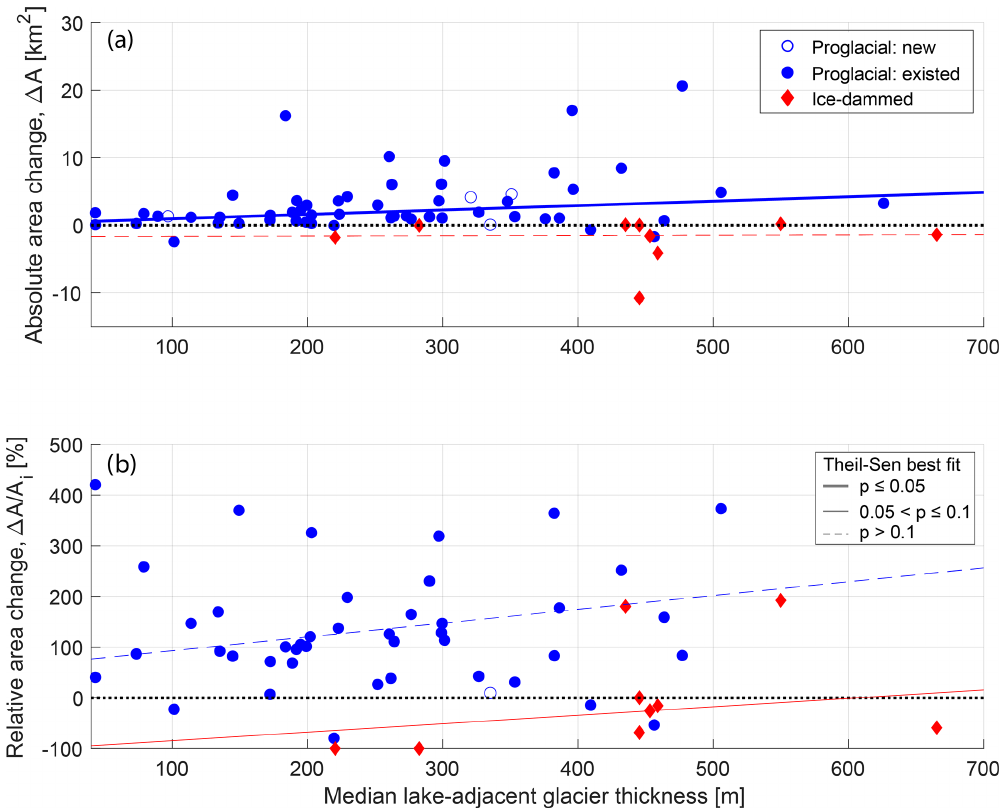
Figure 6. (a) Absolute and (b) relative lake area change as a function of median lake-adjacent glacier ice thickness (see Sect. 2.3) for proglacial (blue circle) and ice-dammed (red diamond) lakes. On both panels, lines show the linear fit to proglacial (blue) and ice-dammed (red) lakes as estimated to by the non-parametric Theil–Sen robust line. Thick solid lines show relationships that are significant at the p ≤ 0 . 05 level; thin solid lines show 0 . 05 < p ≤ 0 . 1 relationships, and thin dashed lines show p > 0 . 1 relationships. All significance values are estimated by the Kendall rank correlation test. The dotted black line shows zero lake area change. Unfilled symbols indicate lakes that appeared during the study